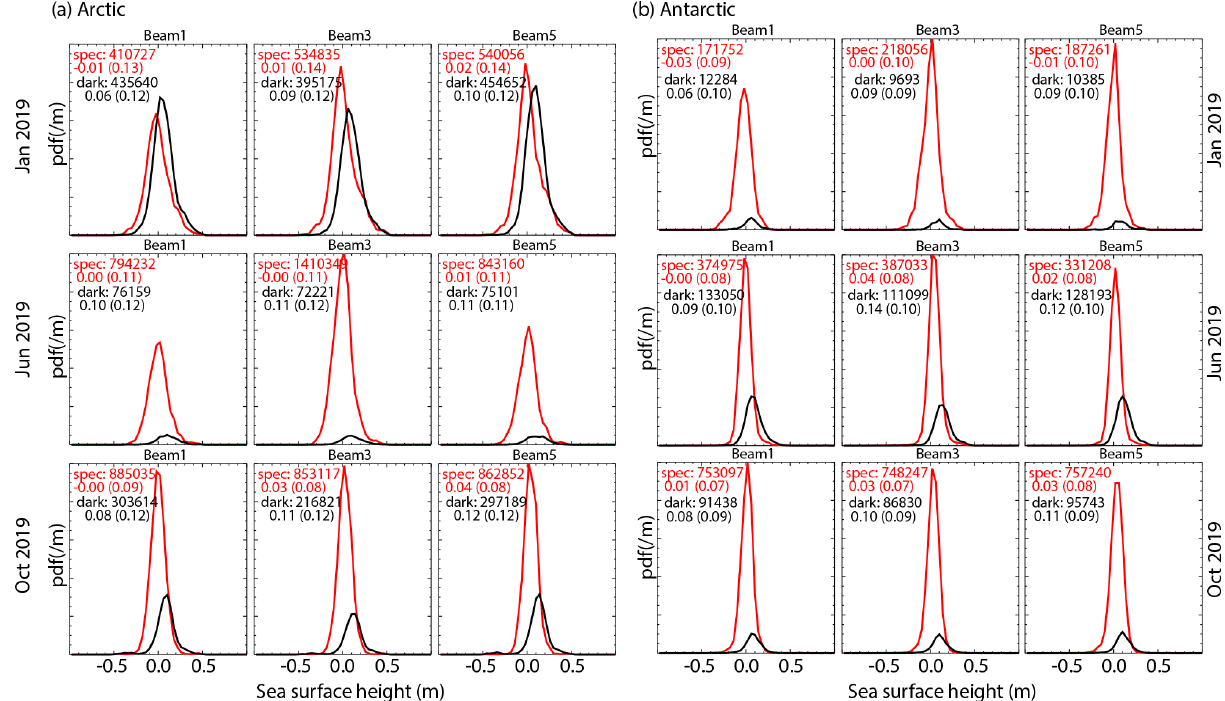
Figure 3. Distribution of surface heights classified with specular (red) and dark returns (black) in the (a) Arctic and (b) Antarctic IS-2 sea ice products for the months of January, June and October 2019. All height segments are subject to additional height filtering in the determination of reference surfaces used in freeboard calculations. Numerical values show the mean and standard deviation of the distributions.